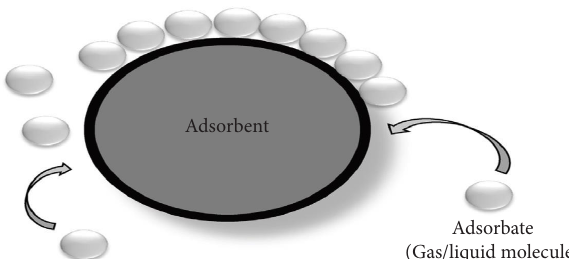
Figure 1: Adsorption process involving the adsorbent and adsorbate